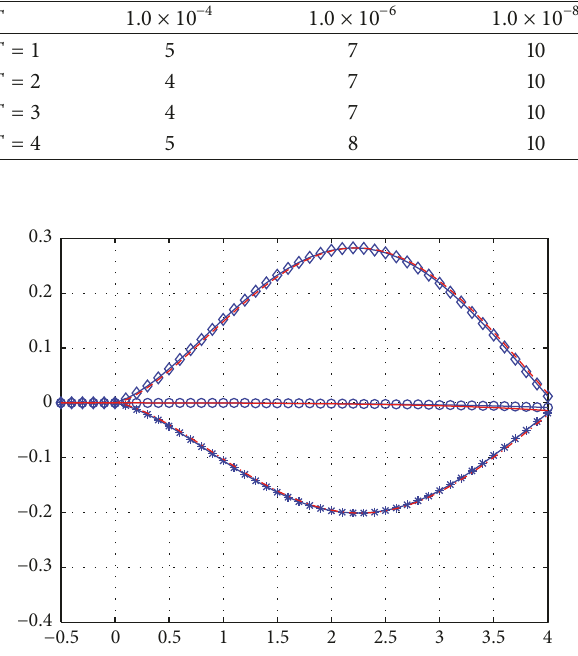
Figure 1: Numerical solutions by using the two methods for